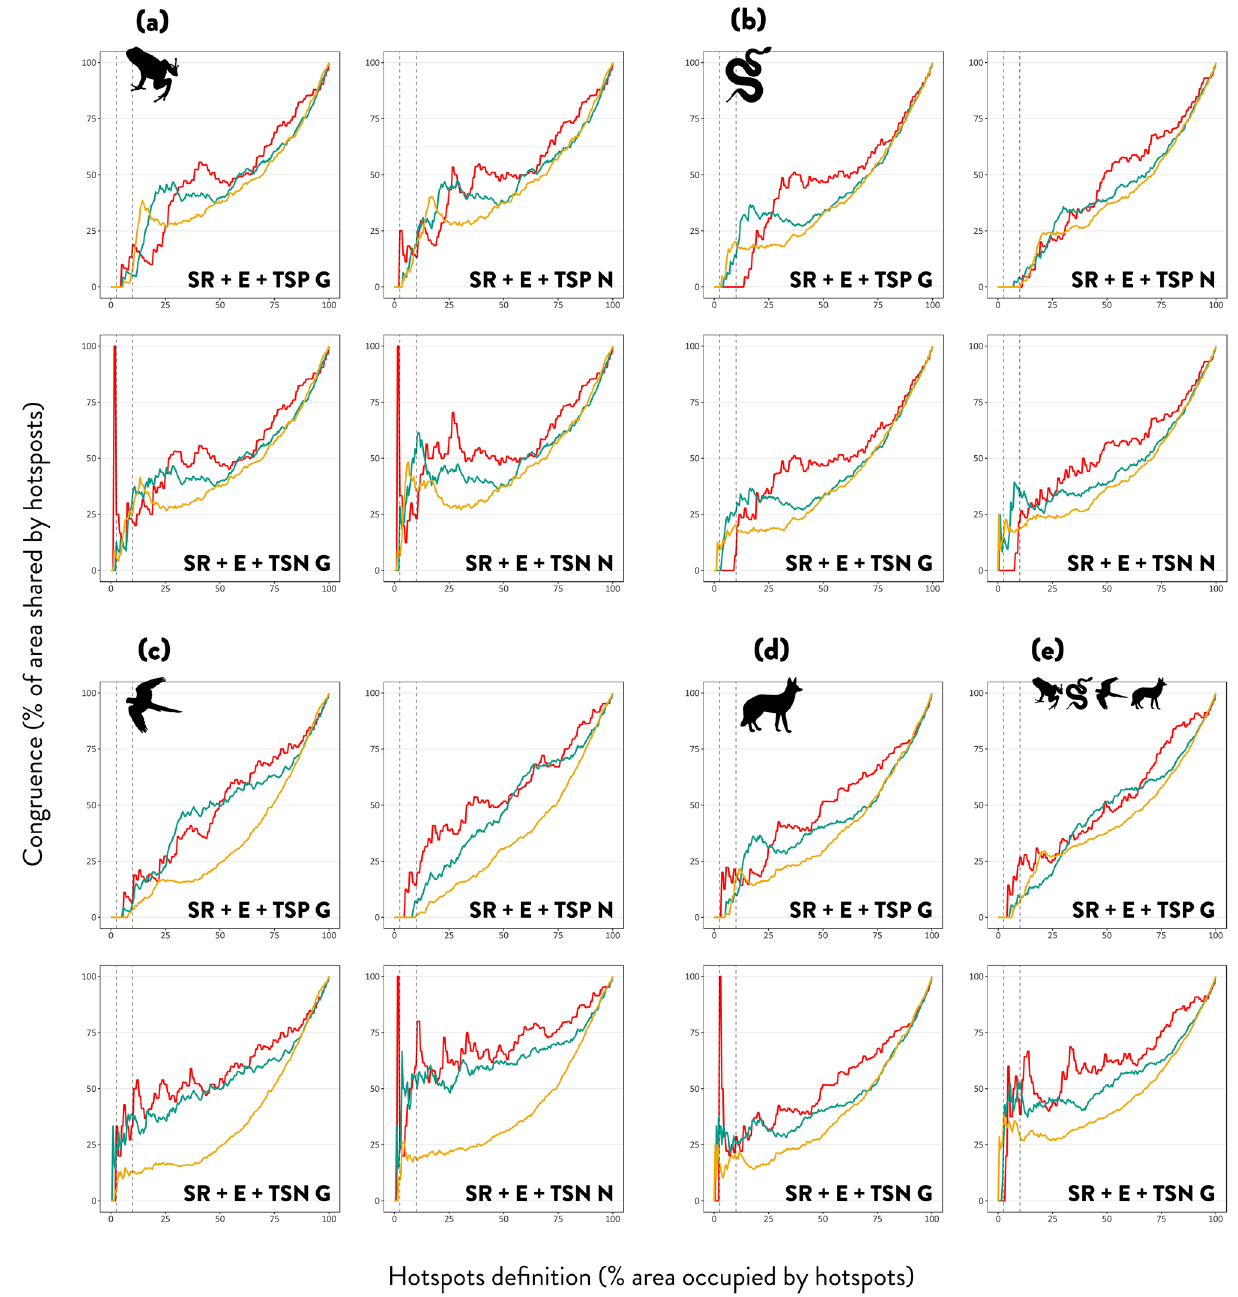
Figure 2. Extent of spatial congruence across types of hotspots. Species-richness (SR), endemism (E), threatened species proportion using the global IUCN assessment (TSP G) or national IUCN assessment (TSP N), and threatened species number using the global IUCN assessment (TSN G) or national IUCN assessment (TSN N). For amphibians ( a ), reptiles ( b ), birds ( c ), mammals ( d ) and tetrapods ( e ). Metrics are analysed with three different grid-cell sizes 50 × 50 km (red line), 25 × 25 km (green line) and 12.5 × 12.5 km (yellow line). Congruence is the number of cells that represent hotspots for all three diversity indices and is measured as the percentage of shared grid-cells over the percentage of land covered by hotspots according to a varying definition from 0 to 100% of the total grid-cells. Vertical dashed lines show 2.5% and 10% hotspot definition across groups and scales, were usually not congruent with those of the species-richness standardised for sam- pling coverage at C max and C 5% values (Fig. 3, Supplementary Fig. S5), though, the patterns of richness at C max and at C 5% were generally consistent. For reptiles, birds and mammals, estimated species-richness was higher in northern areas, opposite to the peaks of observed richness seen in the coast (Fig. 3). For amphibians, maxi- mum values of observed or estimated values of species-richness were more similarly distributed, occupying both northern and southern coastal regions (Fig. 3).